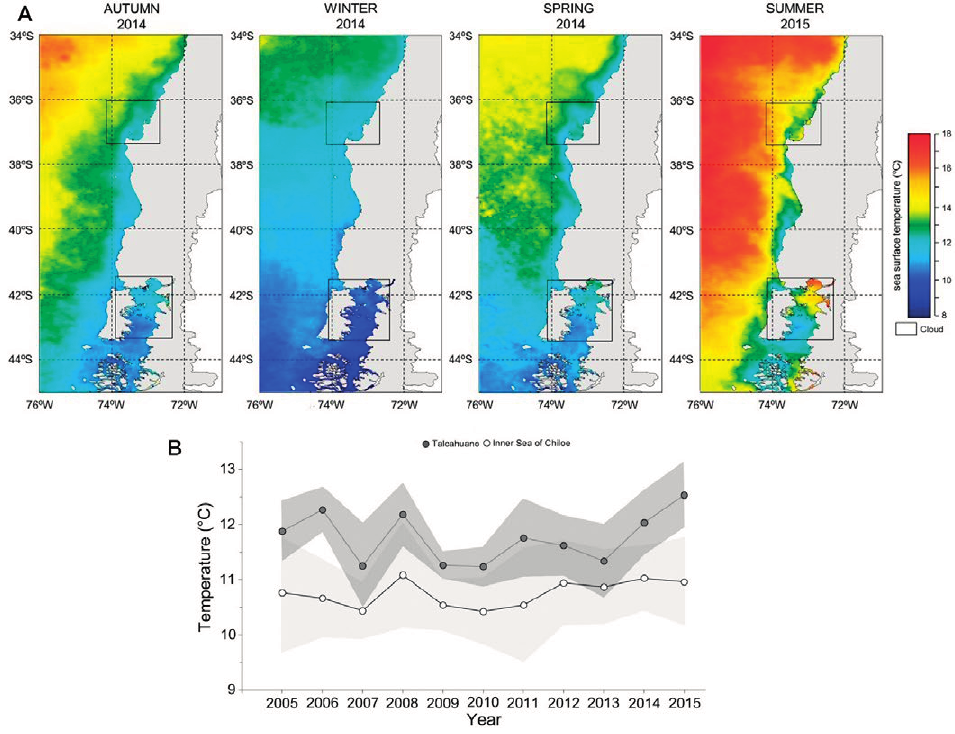
Fig. 3. – Seasonal satellite-obtained mean sea surface temperature along the central-southern Chilean coast showing the two zones (squares) of fish collection during the study (A). Time series (2005-2015) of mean surface temperature during the peak months of spawning in the two zones (Talcahuano, 36.48°S 72.98°W; Inner Sea of Chiloé, 42.10°S 72.94°W). Shaded area represents standard deviations